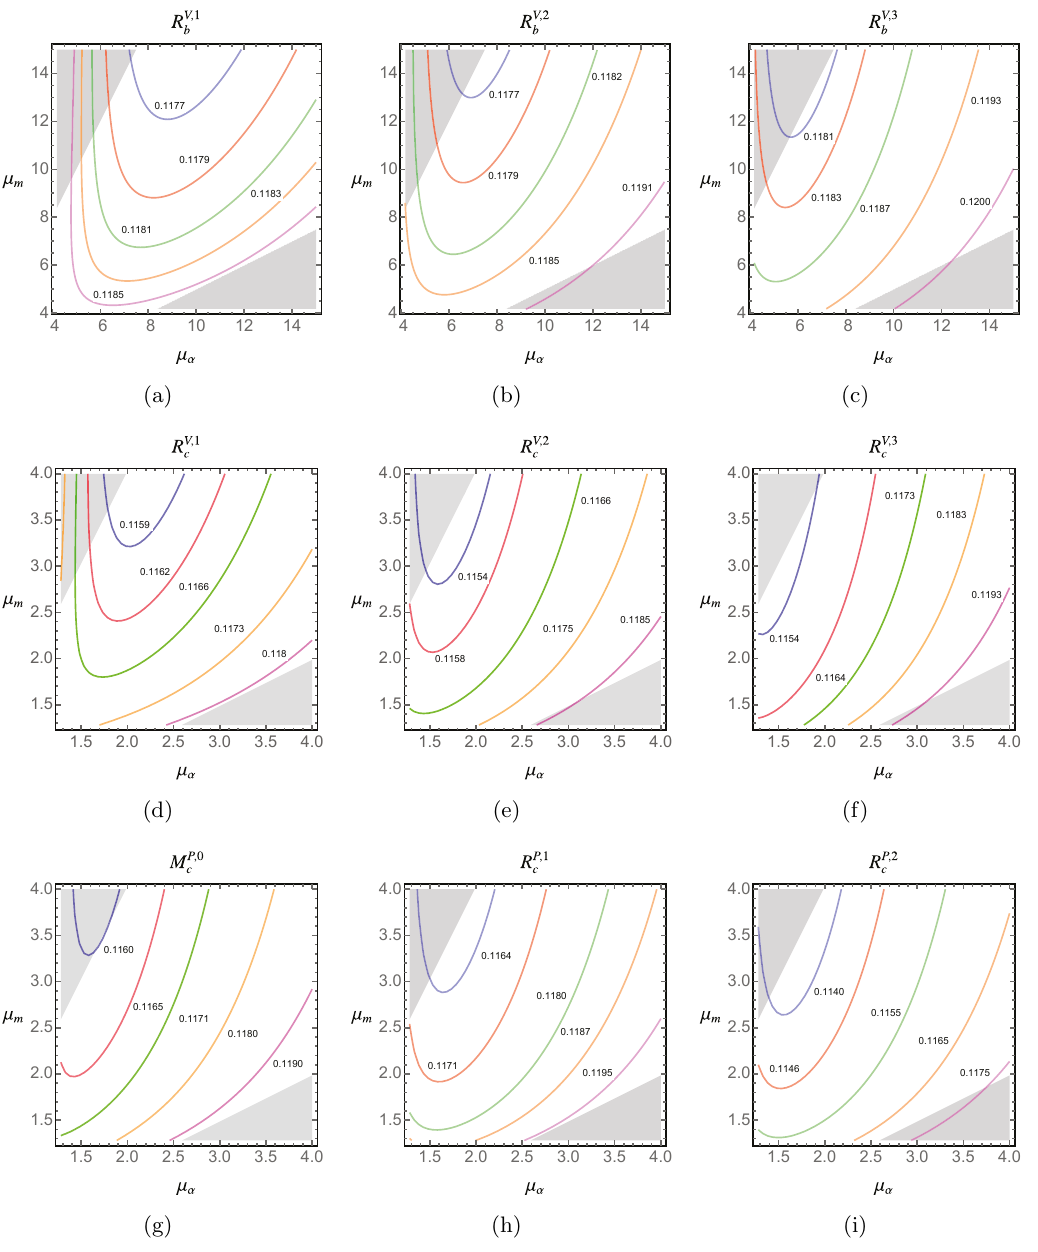
Figure 1 . Contour plots for the extracted value of (cid:11) ( n f =5) s ( m Z ) from di(cid:11)erent perturbative series at O ( (cid:11) 3 ), as a function of the two renormalization scales (cid:22) (cid:11) and (cid:22) m . The three panels at the top s show the result for the bottom vector correlator, the three in the middle (bottom) correspond to the charm vector (pseudo-scalar) correlator. For the six panels showing results for the vector correlator, the left, center and right columns correspond to R V; 1 , R V; 2 and R V; 3 , respectively, while for the q q q pseudo-scalar they show M P; 0 , R P; 1 , and R P; 1 . The shaded gray areas are excluded for (cid:24) = 2. c c c